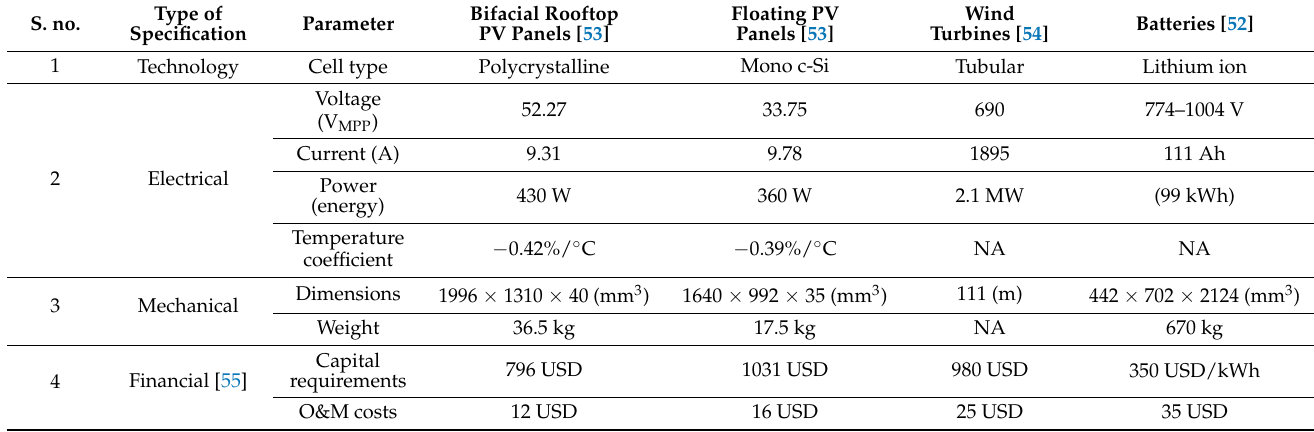
Table 3. Technical details of components, along with